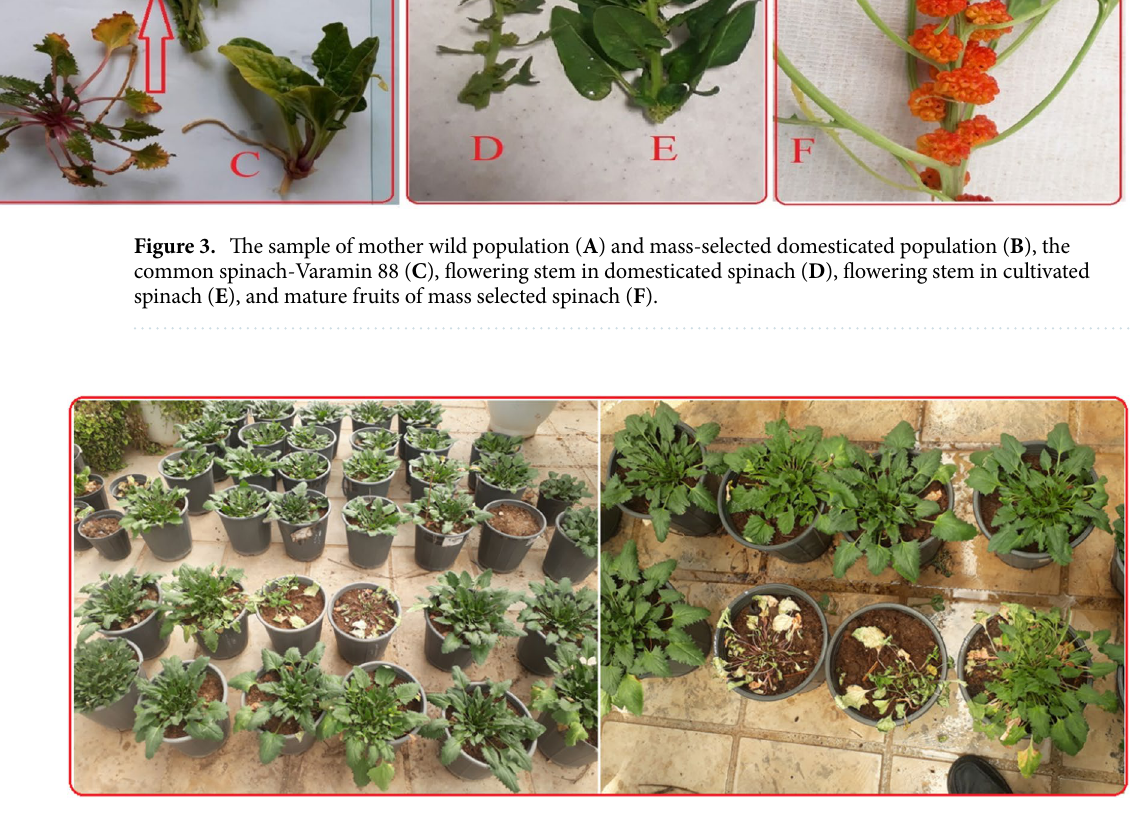
Figure 4. Some greenhouse studies for adaptation of wild spinach populations to put culture conditions. Some plants and genotypes are not able to adapt to agronomic conditions that dry out and wither after a while. About 20 percent of the study population in every generation could not adapt to non-mountainous and non-habitat